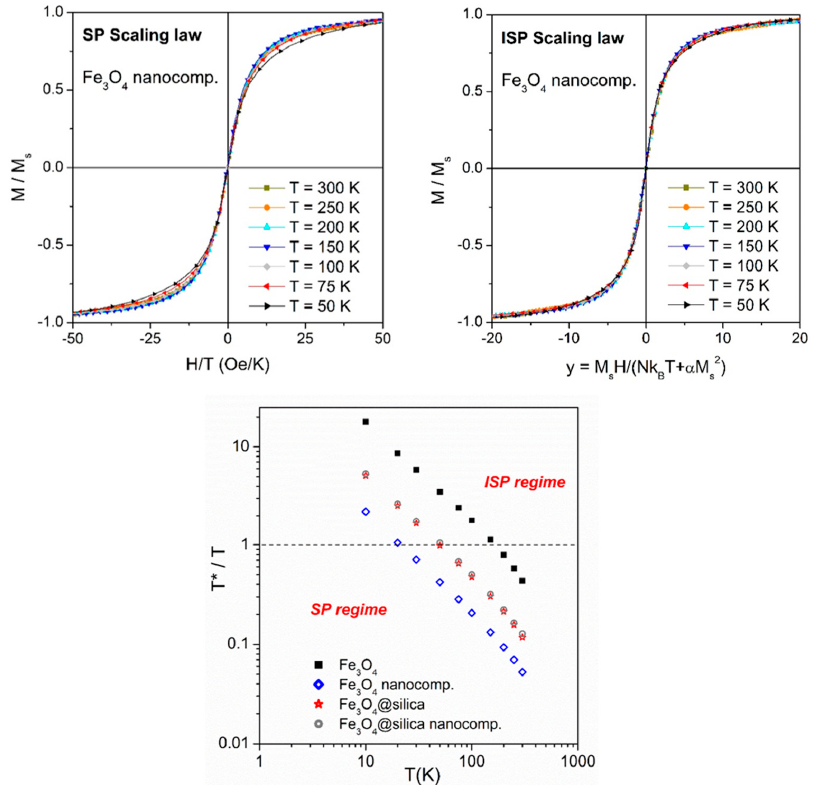
Figure 2. Top panels: Scaling laws in the polymer NC containing bare Fe 3 O 4 NPs. Left : standard superparamagnetic (SP) scaling; right : interacting superparamagnetic (ISP) scaling; bottom : temperature behavior of the ratio T*/T in the same system.